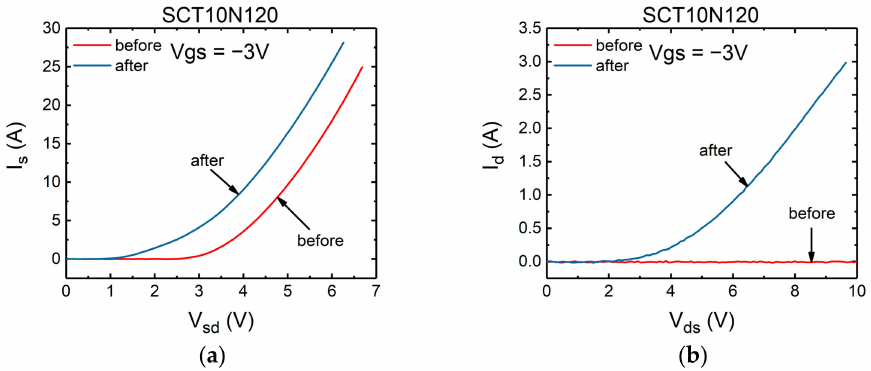
Figure 6. The characteristics of SiC MOSFET’s body diode (SCT10N120) before and after the failure ( a ) forward conduction characteristics, ( b ) reverse blocking characteristics.